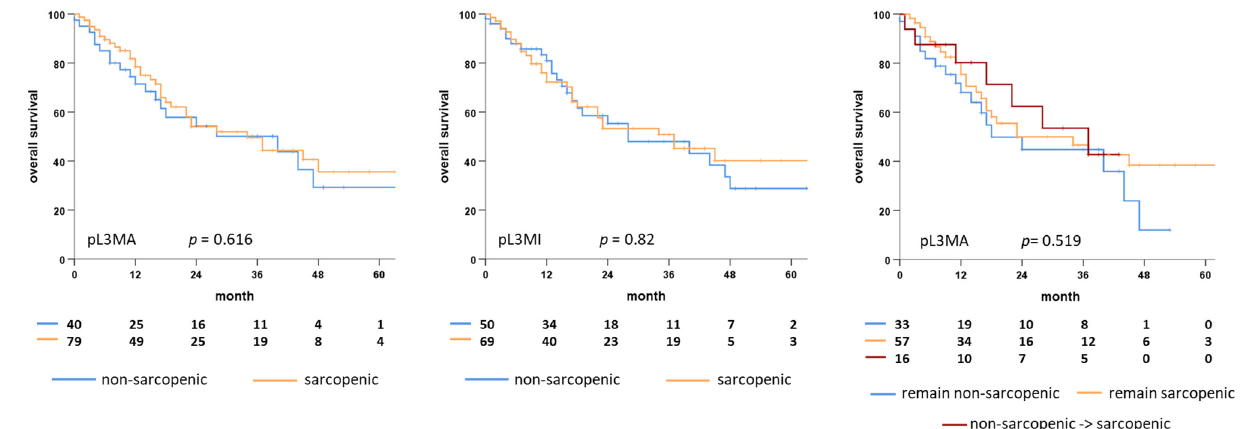
Figure 4. Kaplan Meier plots showing overall survival of post-therapeutic sarcopenic (orange) and non-sarcopenic (blue) elderly HNSCC patients classified for pL3MA (left plot) and pL3MI (middle plot). Right Kaplan Meier plot shows overall survival of three subgroups: blue (patients remaining non-sarcopenic pre- and post-therapeutically) orange (patients remaining sarcopenic pre- and post- therapeutically) and red (pretherapeutic non-sarcopenic patients developing sarcopenia over the course of therapy), all classified for L3MA and pL3MA. pL3MA, calculated post-therapeutic cross- sectional skeletal muscle area at the third lumbar vertebra; pL3MI, calculated post-therapeutic skeletal muscle index at the third lumbar vertebra.